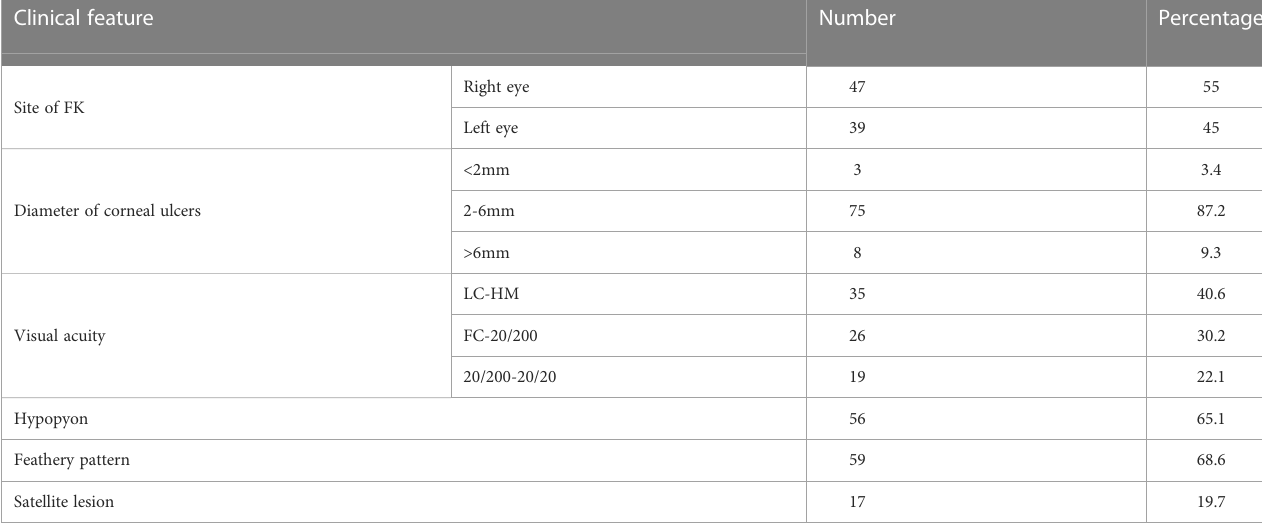
TABLE 2 Clinical feature of patients with fungal